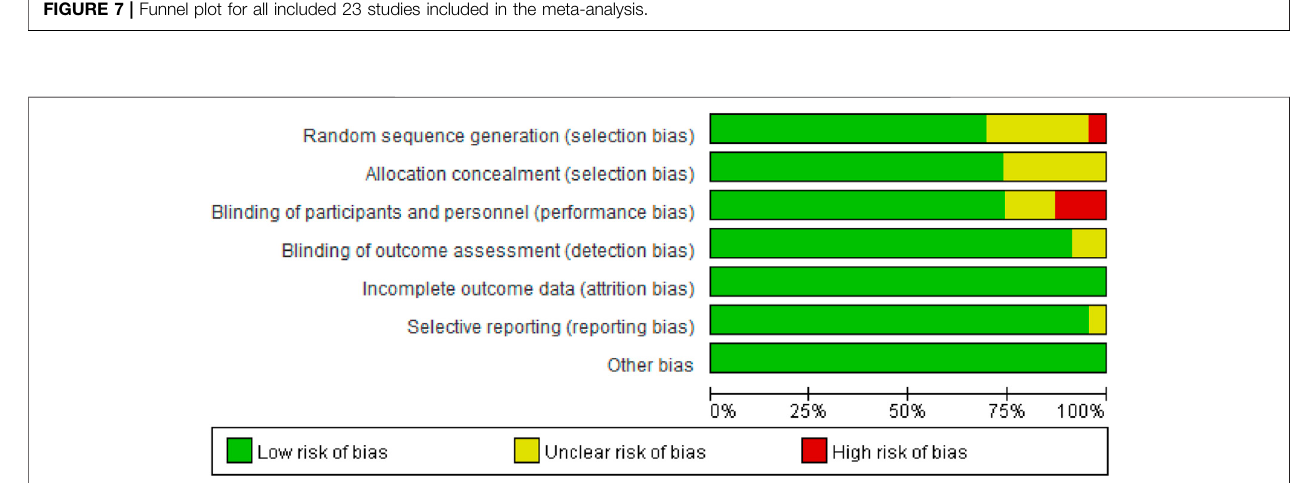
FIGURE 7 | Funnel plot for all included 23 studies included in the meta-analysis.